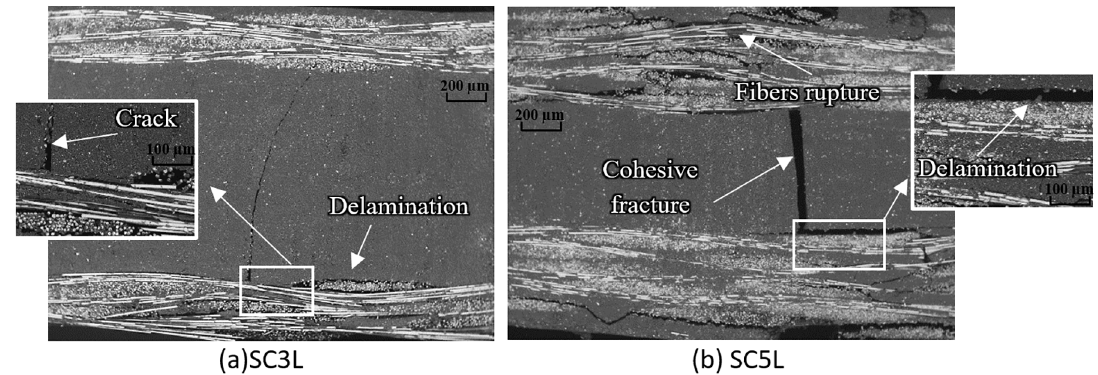
Figure 10. Final failure of sandwich composites (a) SC3L and (b) SC5L